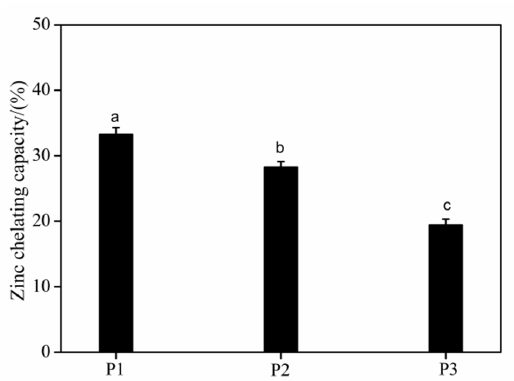
Figure 1. Zinc chelating capacity of three molecular weight peptide fractions; bars in each chart with different letters represent significantly different mean values with P < 0.05.